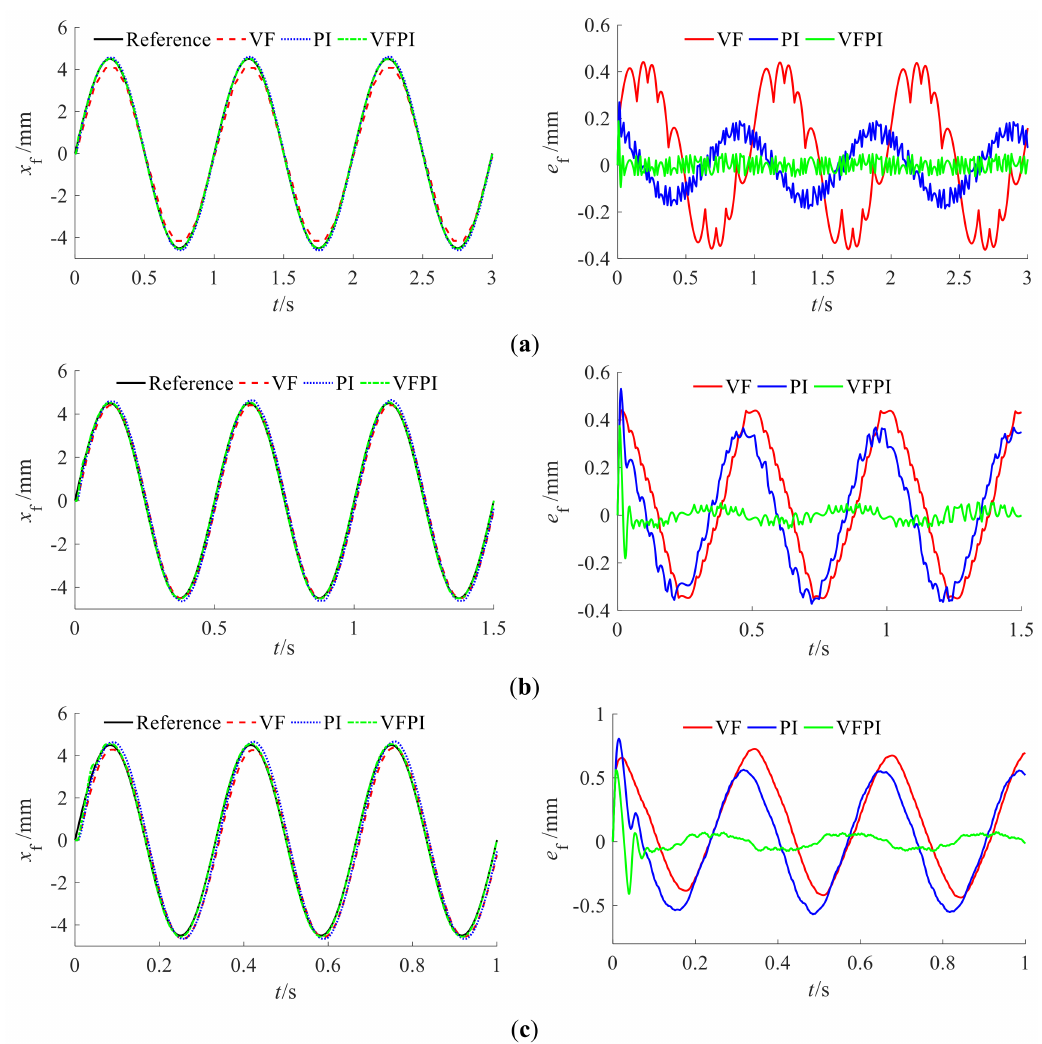
Figure 10. Comparison between the tracking performances while tracking the sinusoidal trajectory with different frequencies (amplitude is 4.5 mm): ( a ) 1 Hz; ( b ) 2 Hz; ( c ) 3